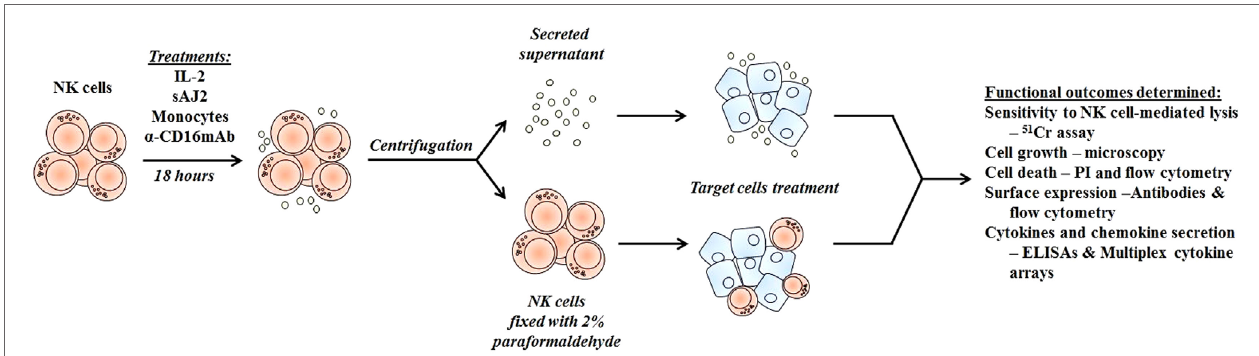
FigUre 1 | schematic representation of steps used to differentiate cancer stem-like cells with nK cell supernatants and fixed nK cells after their activation . Highly purified NK cells were left untreated or treated with IL-2, sAJ2, monocytes, and/or anti-CD16mAb for 18 h, after which the treated NK cells were centrifuged, and the supernatants were removed and used to treat target cells. For cell–cell contact studies, treated NK cells were fixed with freshly prepared 2% paraformaldehyde for 15 min, washed three times with 1 × PBS and added to target cell cultures. After the differentiation period, NK supernatants or fixed NK cells were removed from target cell cultures, and the targets were used in various